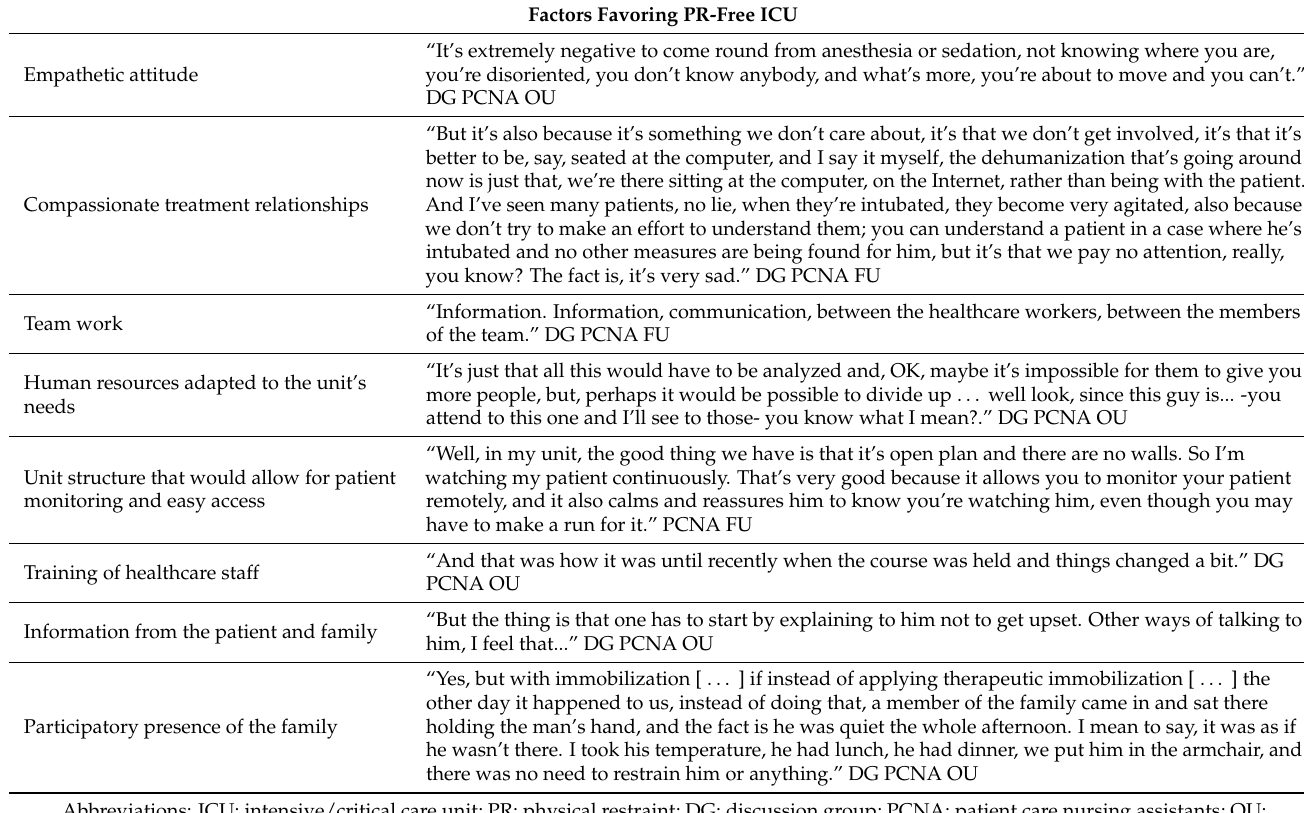
Table 10. Factors favoring PR-free intensive/critical care units. Factors Favoring PR-Free